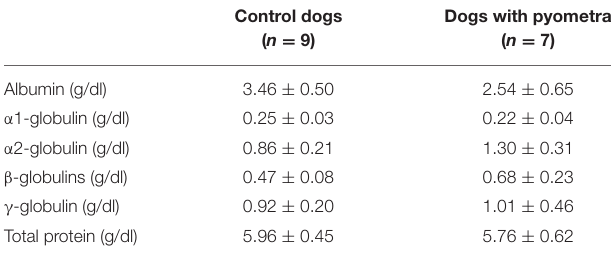
TABLE 1 | Serum protein levels in control dogs and dogs with pyometra separated by serum protein electrophoresis (mean ± standard deviation).